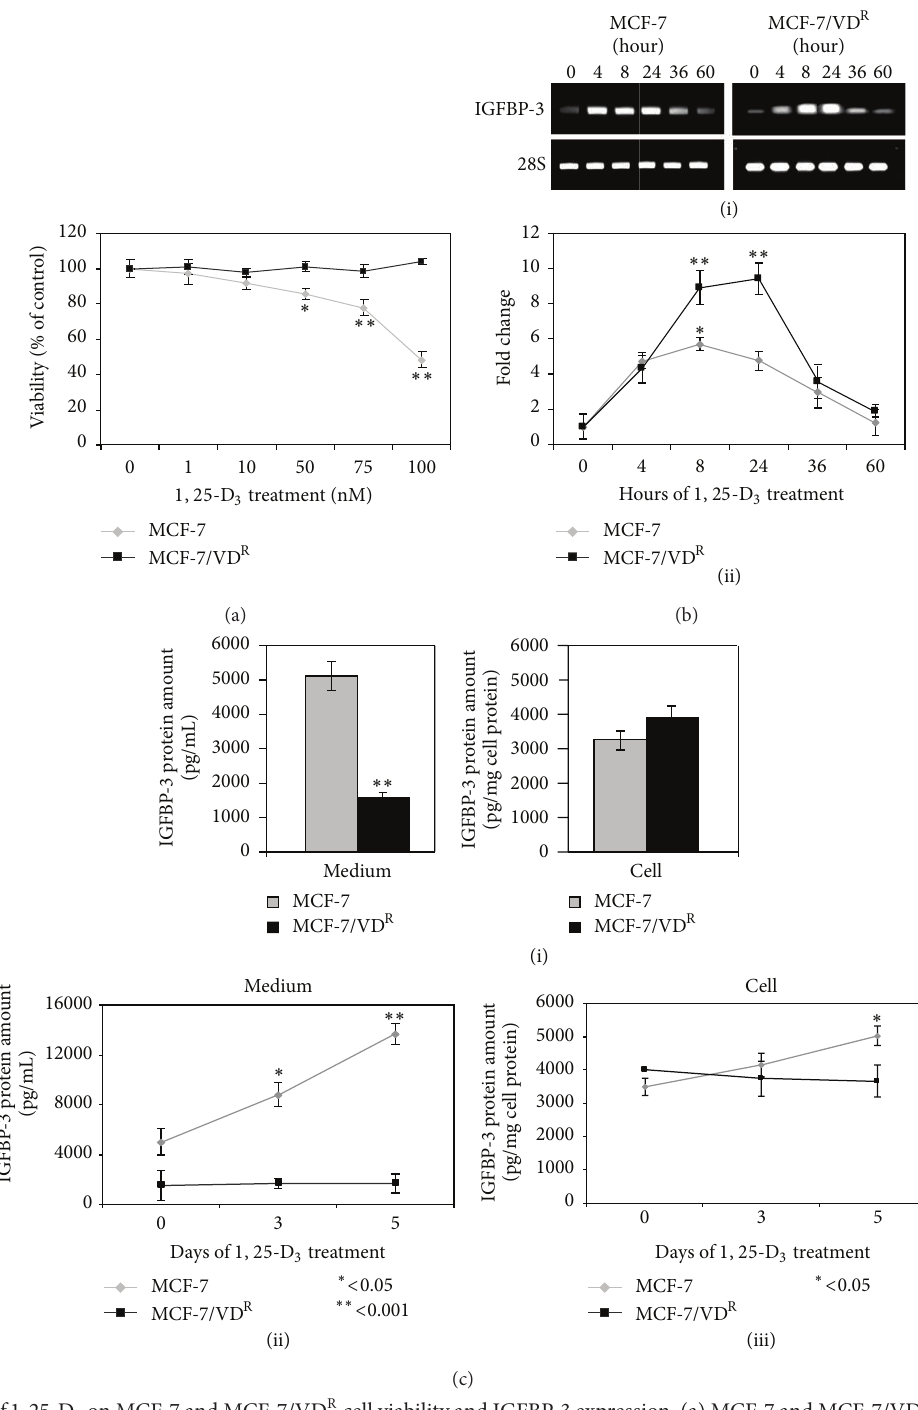
Figure 1: Effect of 1, 25-D 3 on MCF-7 and MCF-7/VD R cell viability and IGFBP-3 expression. (a) MCF-7 and MCF-7/VD R cells were treated with increasing concentrations of 1, 25-D 3 (up to 100nM) or 0.1% ethanol vehicle as a control for 6 days. Cell viability was determined by neutral red assay. Means of 3 separate experiments are shown. ∗ 𝑃 < 0.05 and ∗∗ 𝑃 < 0.001 are statistically significant compared to the control. (b) (i) MCF-7 and MCF-7/VD R cells were treated with 100nM 1, 25-D 3 for up to 60 hours. IGFBP-3 mRNA expression was measured by RT-PCR. 28S mRNA expression was used as house-keeping gene. Nontreated cells were used as controls. (ii) Densitometric analysis of of IGFBP-3 mRNA expression. Data shown means of three separate experiments. (c) Intracellular IGFBP-3 levels and secretion into medium was determined by ELISA in MCF-7 and MCF-7/VD R cells. (i) IGFBP-3 expression and secretion into the medium in untreated MCF-7 and MCF-7/VD R cells. (ii) IGFBP-3 secretion into the medium in MCF-7 and MCF-7/VD R cells treated with 100nM of 1, 25-D 3 for up to 5 days quantitated by ELISA. (iii) The amount of intracellular IGFBP-3 production by MCF-7 and MCF-7/VD R cells treated with 100nM of 1, 25-D 3 was measured at day 0, 3, and 5 by ELISA. Means of 3 separate experiments are shown. ∗ 𝑃 < 0.05 and ∗∗ 𝑃 < 0.001 are statistically significant compared to the